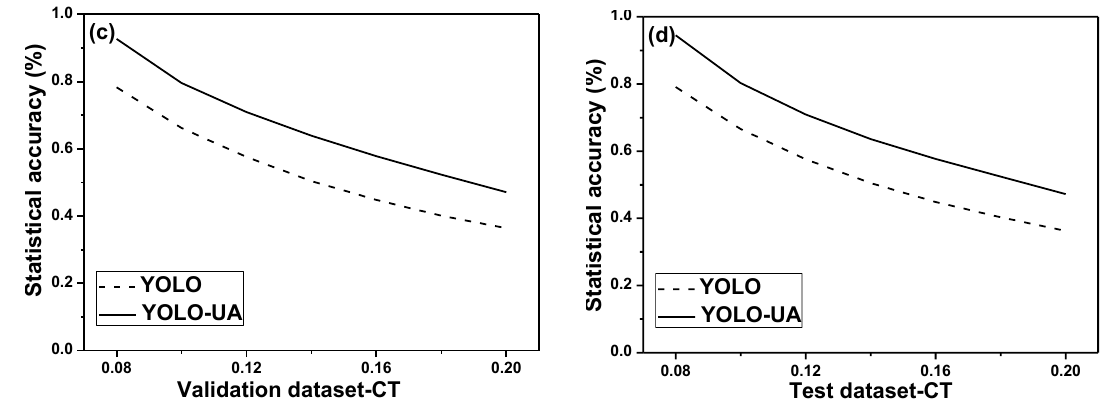
Figure 6. E ff ects of CT and NT impact factors on statistical accuracy, ( a ) NT on the accuracy of verification sets, ( b ) NT on the accuracy of test sets, ( c ) CT on the accuracy of verification sets, and ( d ) CT on the accuracy of test sets.